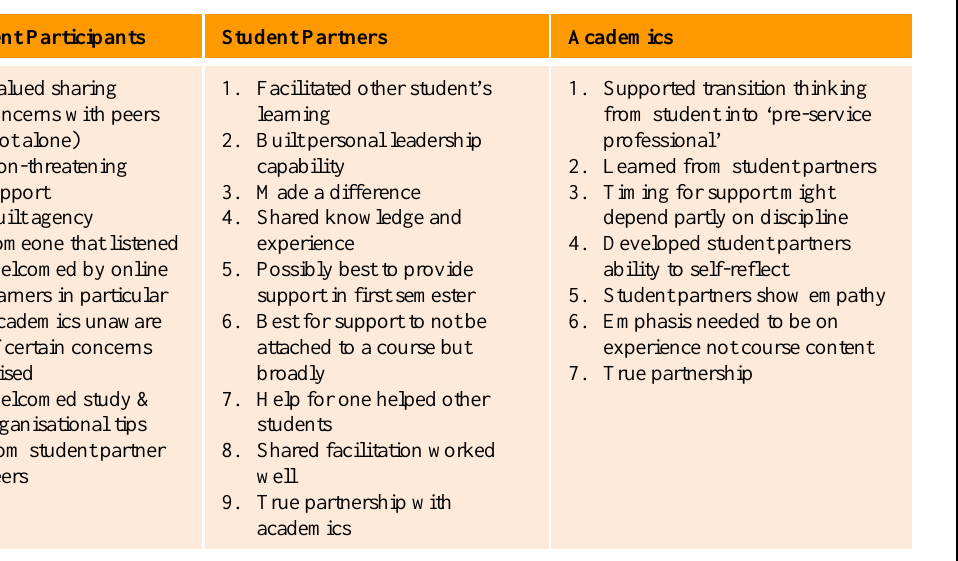
Table 1: Collating initial findings according to participant